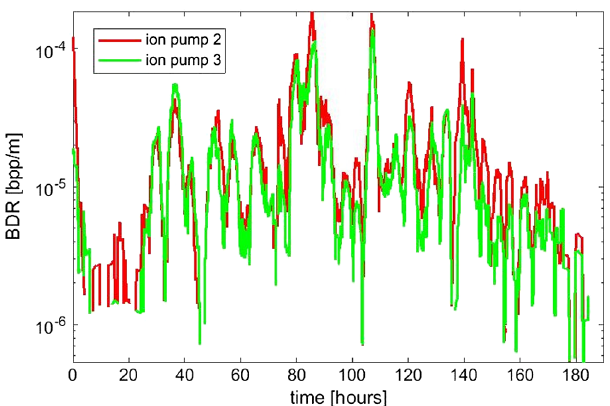
FIG. 20. Calculated BDR as measured by peaks on a vacuum measured by ion pumps 2 and 3 and considering a moving time window of about 10 4